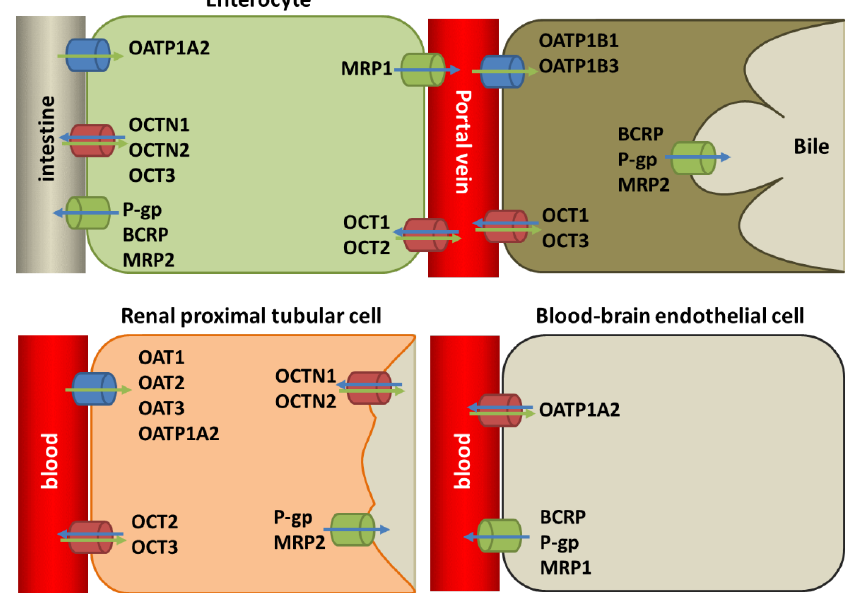
Figure 2. Overview of transporters and their tissue localization relevant for TKI ADME, categorized according to influx, efflux of bidirectional transporters. Arrows indicate direction of drug transport.